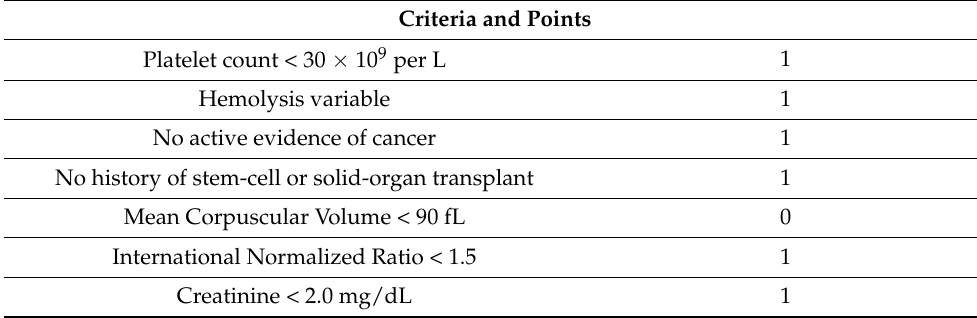
Table 3. PLASMIC score calculated 6 h after admission.